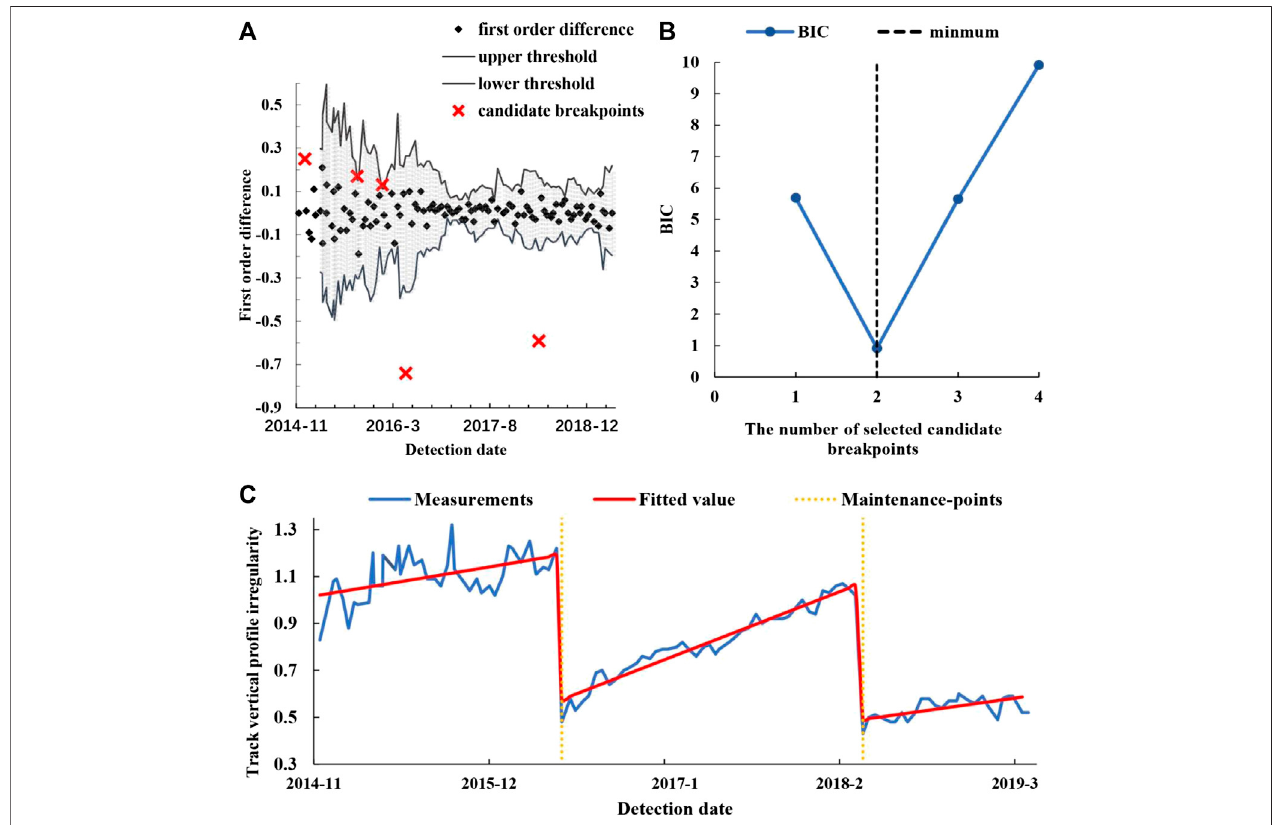
FIGURE 5 | The identi fi ed maintenance-points and piecewise fi tting model of section one: (A) the candidate breakpoints identi fi ed by the adaptive thresholding method; (B) the value of BIC for a different number of selected candidate breakpoints; (C) the piecewise fi tting model.